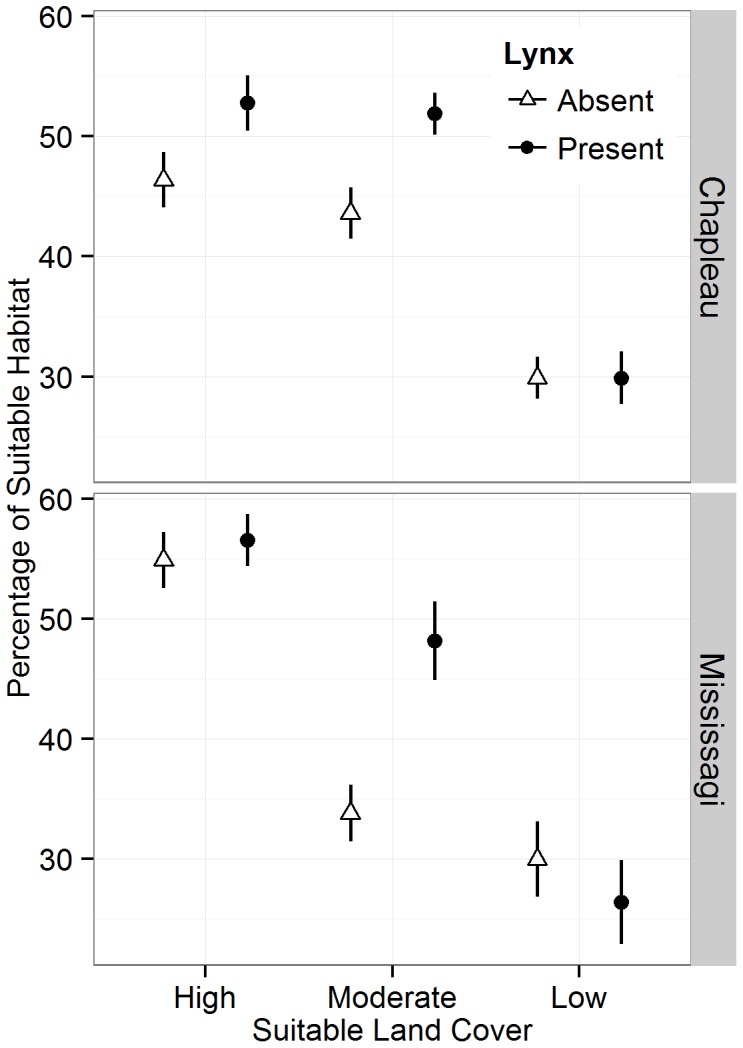
Mean percentage of suitable habitat (with standard errors) for lynx presences compared to pseudo-absences at the 25 km2 scale in the regions of Chapleau and Mississagi with three levels of suitable land cover.